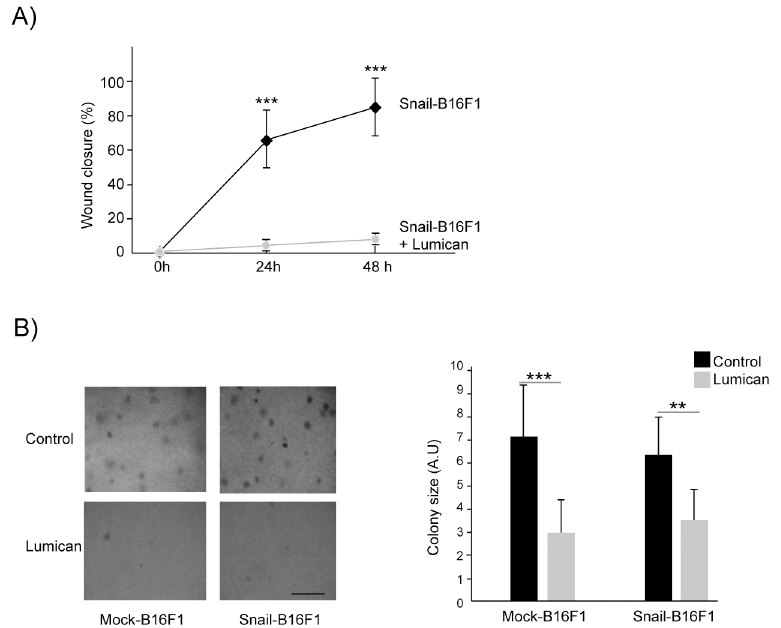
Fig 5. Lumican inhibits Snail overexpressing B16F1 cell functional properties. (A) Cell migration of Snail overexpressing B16F1 cells (clone Snail19-B16F1) in presence or absence of lumican (100 nM) after 24h and 48h; n = 2, *** p < 0.001 (B) Colony formation assay of mock and Snail overexpressing B16F1 cells (clone Snail19-B16F1) in absence or presence of lumican (100 nM); Representative images of cell colonies are displayed at the inserts 14 days after seeding. The quantification of the colony diameter was performed using Image Tool software. Graphs represent the mean size of 100 colonies ± SD from two independent experiments. ( ** p < 0.01, *** p < 0.001). Scale bar inserts: 200 μ